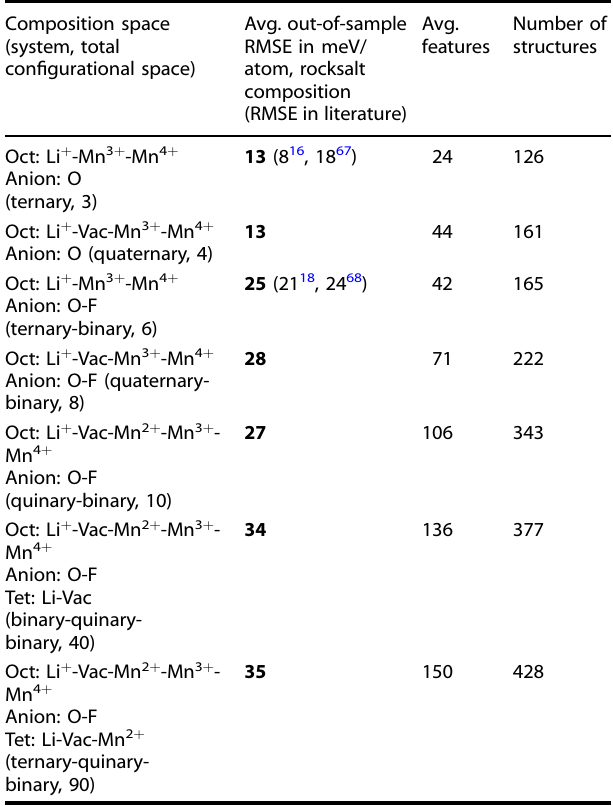
Table 2. The performance of various composition models using only pairs up to 7 Å and triplets up to 5 Å and the Ewald energy.